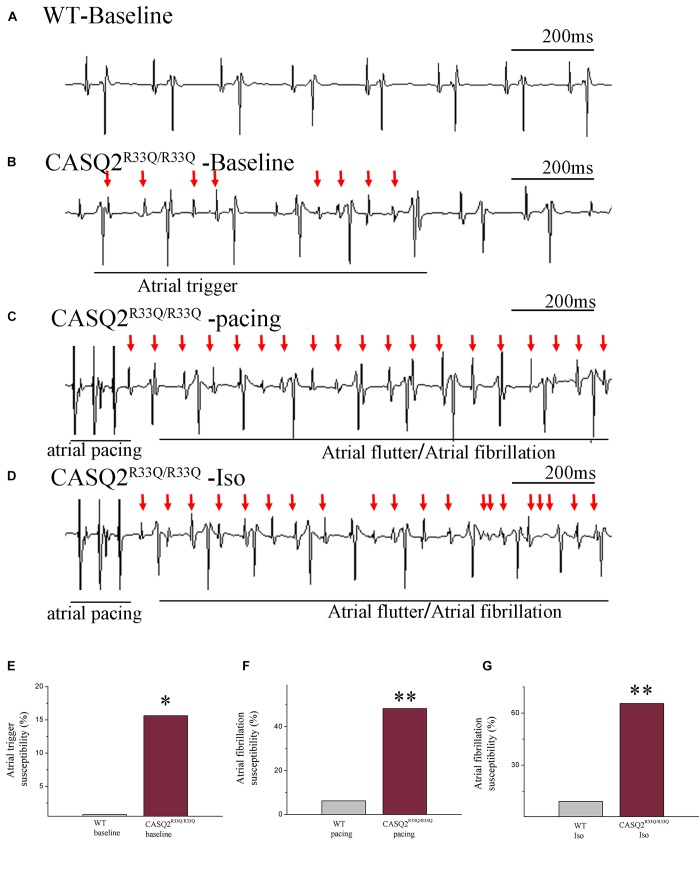
Casq2R33Q/R33Q hearts are susceptible to atrial tachyarrhythmia, indicated by the (A) ECG record in the Casq2R33Q/R33Q mice compared with sinus rhythm in the WT mice under intraesophageal pacing at 25 Hz. (B) Atrial tachyarrhythmia resembles atrial trigger, and (C,D) atrial flutter and AF were observed in Casq2R33Q/R33Q hearts. The rate of atrial tachyarrhythmia susceptibility under (E) baseline status, (F) pacing condition, and (G) Iso stimulation in each group. (F) The probability of AF induction at 25 Hz burst pacing in the Casq2R33Q/R33Q mice and the WT mice given 1.5 mg/kg Iso. ∗P < 0.05 vs. WT, ∗∗P < 0.01 vs. WT.